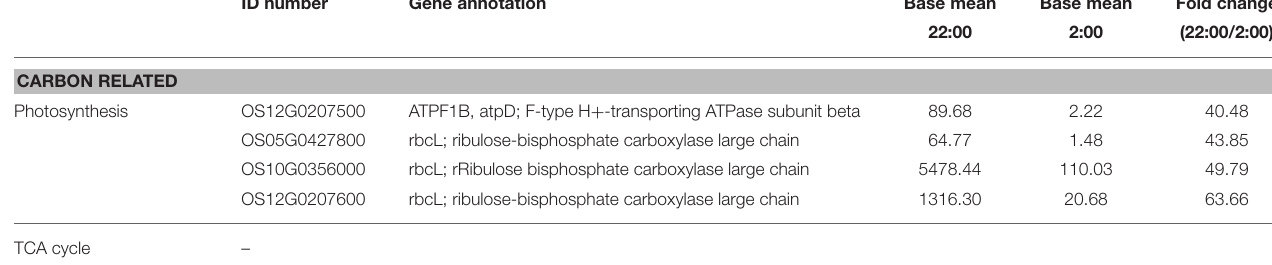
TABLE 5 | Differentially expressed genes involved in carbon and nitrogen metabolism at the time of 22:00 compared to 2:00. ID